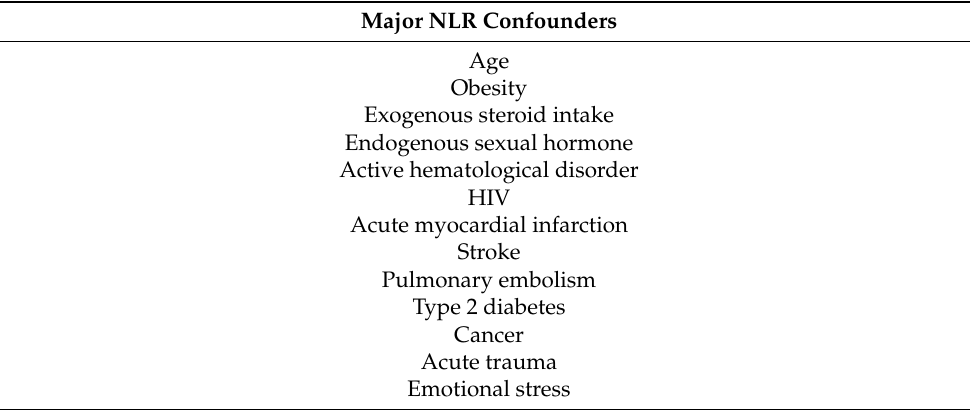
Table 1. Major condition that could determine a “false” increase in NLR